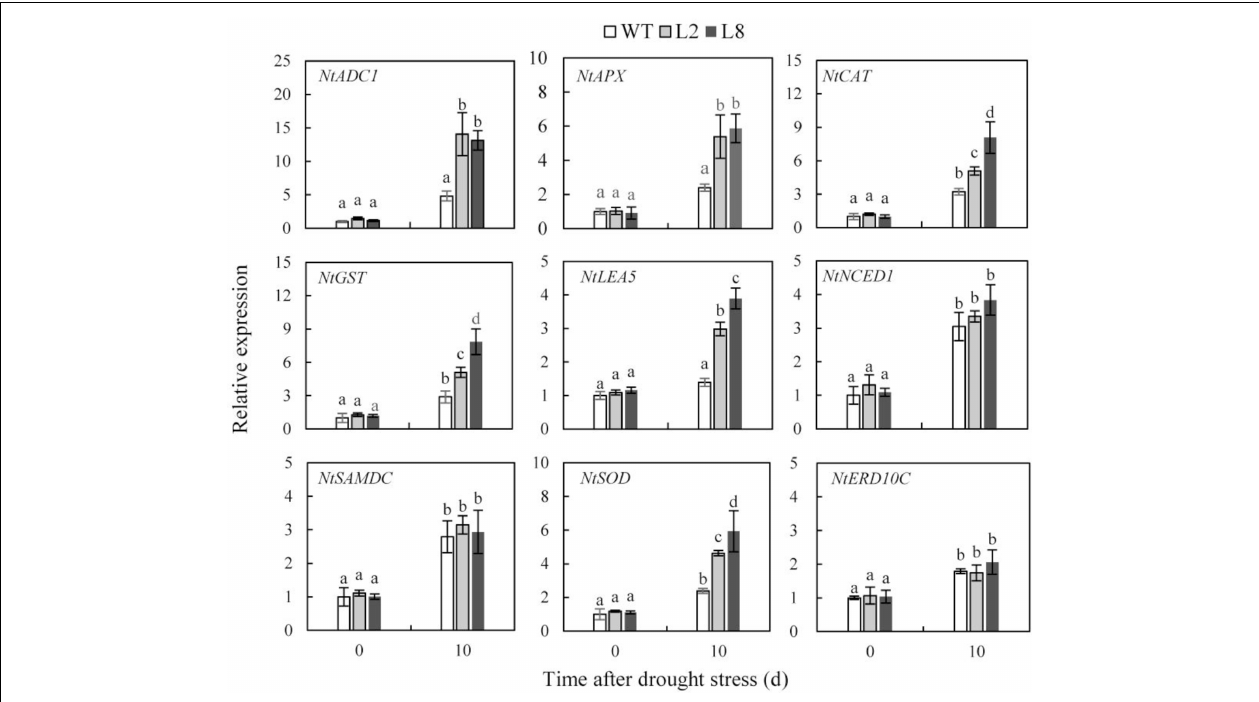
FIGURE 8 | Expression levels of stress-relative genes in WT and transgenic lines (L2 and L8) under drought stress. Six-week-old seedlings were withheld water for 10 days. The tobacco leaves were sampled to extract the total RNA to synthesize cDNA. Expression levels of nine genes were detected. NtActin was used as the internal control. Error bars represent SD and values with different letters are significant at P <